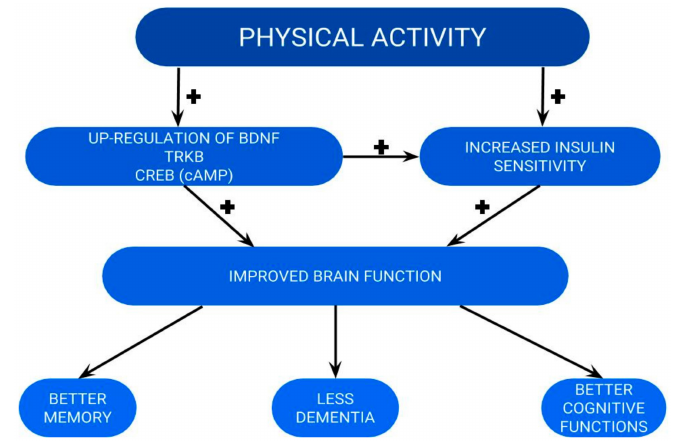
Figure 2. Physical activity and brain function—a place for BDNF